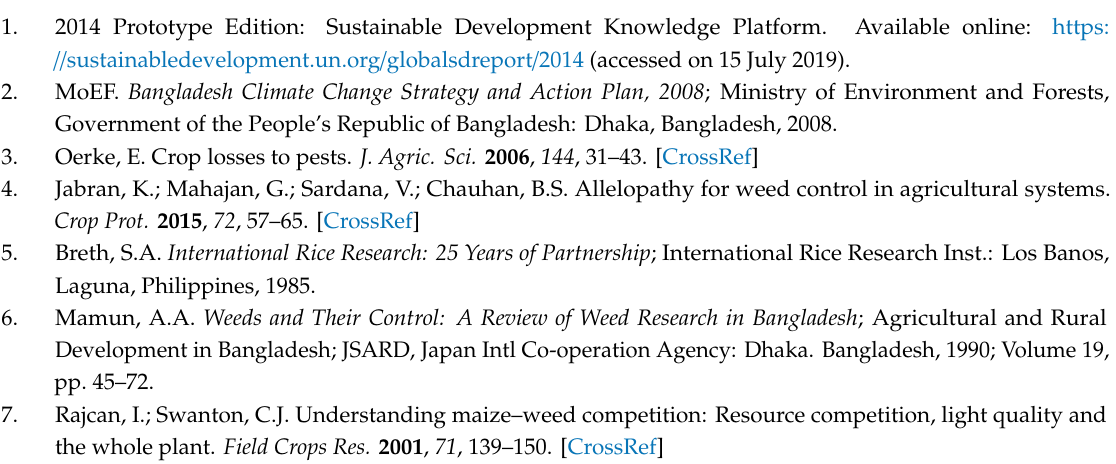
Table S1: The radicle and hypocotyl elongation percentage of L. sativa seedlings in the DP method containing 200 mg of dry plant materials (103 plant